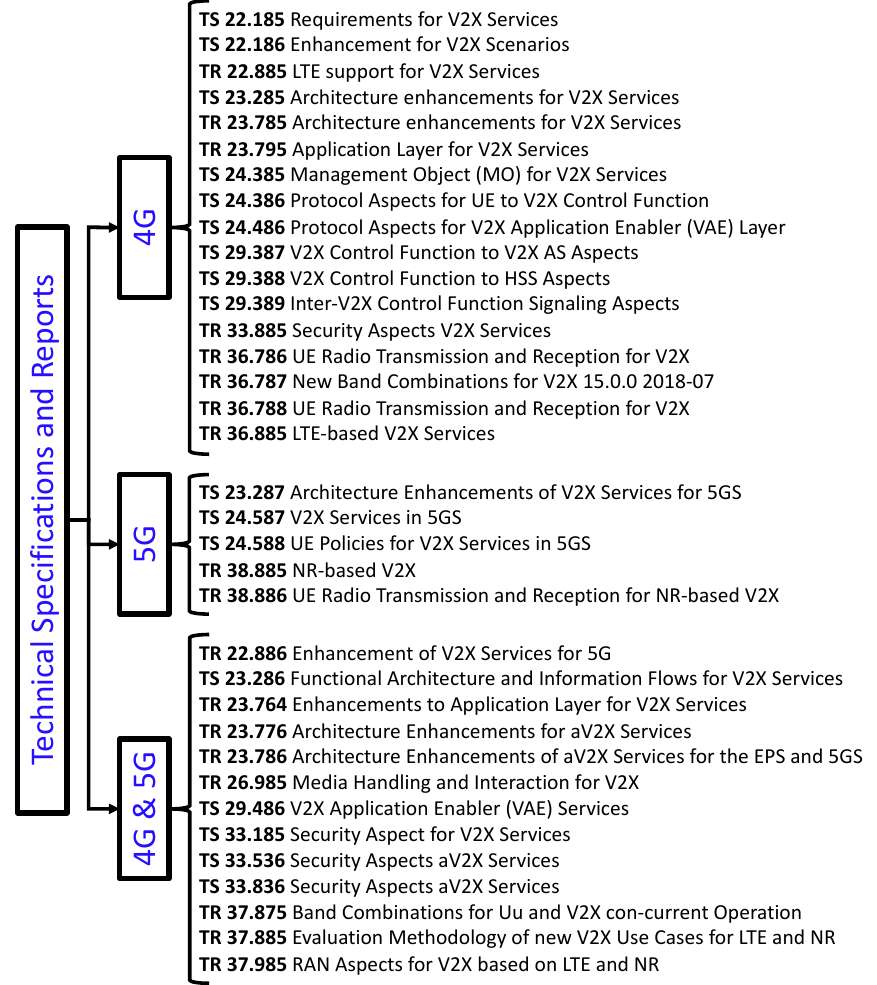
Figure 7. Taxonomy and 3GPP technical documents for autonomous